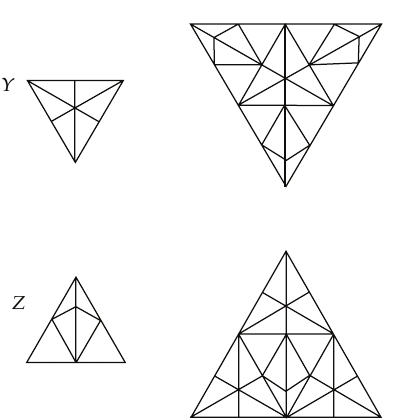
Figure 10: Inflation rules for the patches Y and Z in T